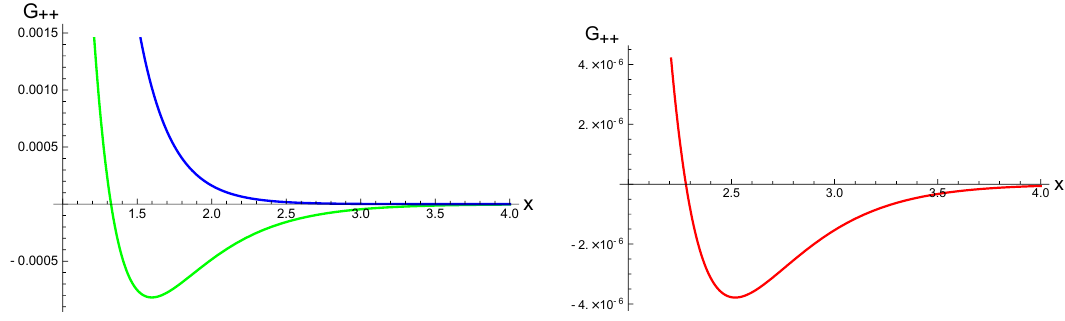
Figure 16 . The correlator G ++ ( x ). Left: the case j m 2 (cid:0) (cid:3) 2 j (cid:21) 2. The blue line represents the case (cid:3) 2 (cid:0) m 2 (cid:21) 2 and the green line the case m 2 (cid:0) (cid:3) 2 (cid:21) 2. Right: the case j m 2 (cid:0) (cid:3) 2 j < 2. Only the blue line corresponds to a re(cid:13)ection positive correlator for all